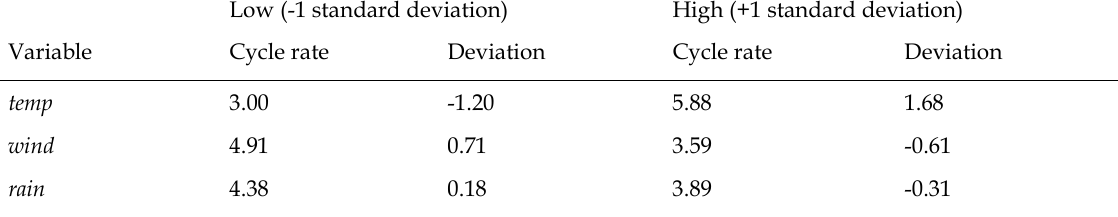
Table 3. Cycle rate sensitivity for deviations from average values in weather